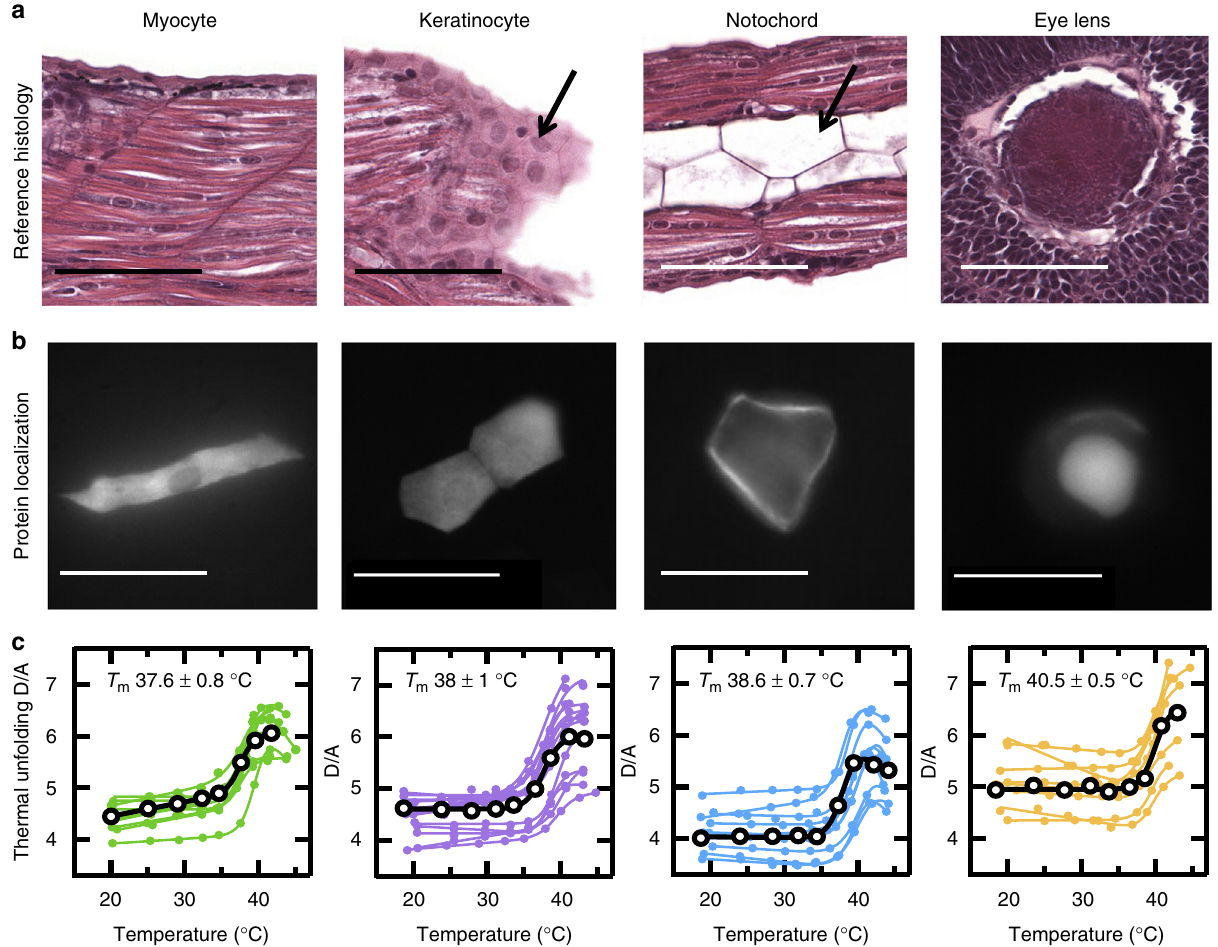
Fig. 2 FRET-PGK stability and kinetics monitored in zebra fi sh myocyte, keratinocyte, notochord, and eye lens cells. a Hematoxylin and eosin histological virtual slides of 2 day old zebra fi sh myocyte, keratinocyte, notochord, and eye lens cells. Cell morphology was compared to histology in the zebra fi sh bio- atlas to con fi rm nonectopic promoter dependent expression. Myocyte (left) and keratinocyte (left of middle) images from frame http://bio-atlas.psu.edu/ zf/view.php?s = 528&atlas = 49. Notochord (right of middle) image from frame http://bio-atlas.psu.edu/view.php?s = 421&atlas = 48. Eye lens (right) image from frame http://bio-atlas.psu.edu/zf/view.php?s = 530&atlas = 49. All scale bars are 50 μ m. b Promoter dependent tissue expression. EF1 α / β -actin promoter localizes PGK expression in myocytes (left). Krt5 promoter localizes PGK expression in keratinocytes (left of middle). Mouse α A-crystallin promoter localizes PGK expression in the notochord (right of middle). Zebra fi sh α A-crystallin promoter localizes PGK expression in eye lens cells (right). Fluorescence microscopy images of green channel under blue excitation collected at 63× magni fi cation. All scale bars are 50 μ m. Source data are provided as a Source Data fi le. c Thermal stability of PGK in differentiated tissues monitored by fl uorescence microscopy. The signal from two-color FRET experiments is reported as donor/acceptor (D/A) ratio. A sigmoidal fi t with pre- and post- transition baselines is overlaid on the data. Reported melting temperatures ( T m ) are averaged over ~8 fi sh and are presented as mean ± SD. Source data are provided as a Source Data fi